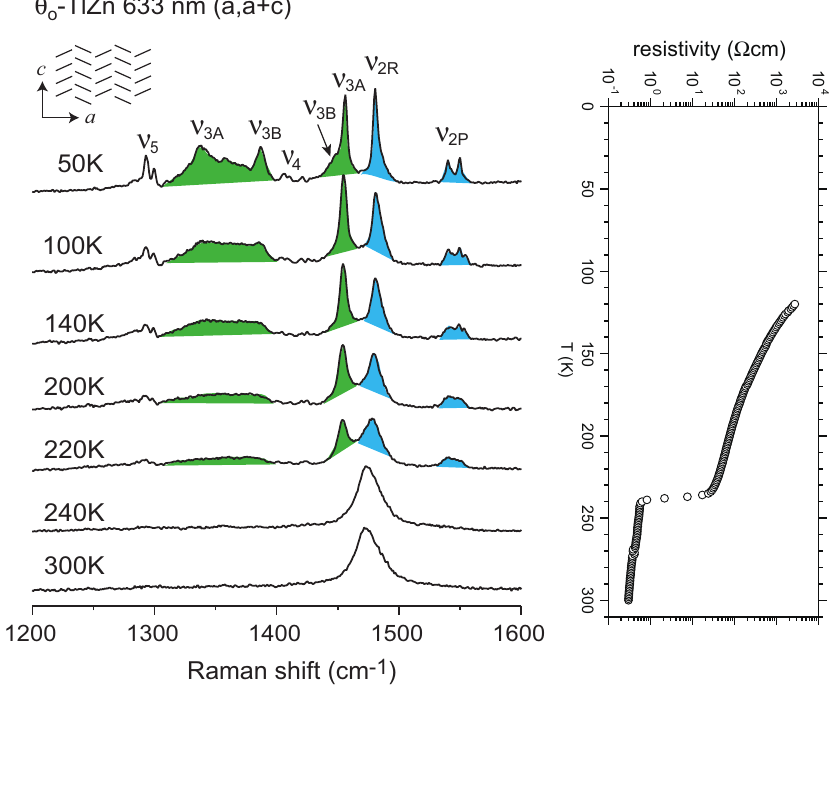
Figure 11. Temperature dependence of the Raman spectrum of θ along with the electrical resistivity. The inset shows the herringbone arrangement of BEDT- TTF with respect to the crystallographic axes. The spectral change is almost exactly the same as that of θ -(BEDT-TTF) Figure 4 of ref.